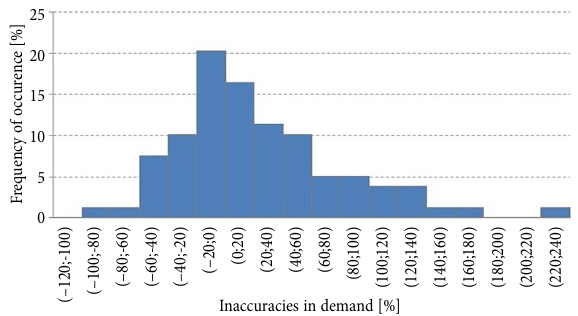
Fig. 3. Inaccuracies of demand forecasts for roads in 79 proj- ects (inaccuracy is measured as actual minus forecast traffic in percentage of forecast traffic, thus, a negative sign refers to lower than actual)